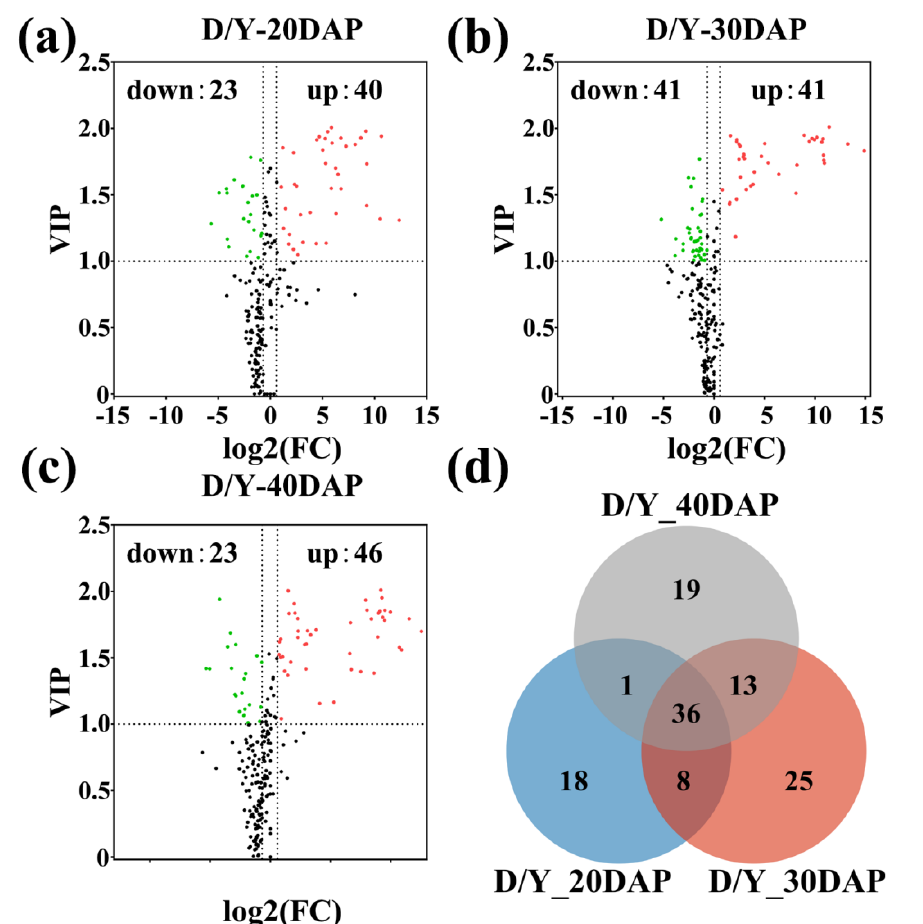
Figure 2. Identification of common differentially abundant metabolites in developing seeds of B . juncea . ( a–c ) Volcano plots of differentially abundant metabolites. Each point in a volcano plot represents a metabolite; the abscissa represents the logarithm of the quantitative difference multiples of a metabolite in two samples, and the ordinate represents the variable importance in project (VIP) value. The green dots represent down-regulated differentially abundant metabolites, the red dots represent up-regulated differentially abundant metabolites, and the black dots represent metabolites with no difference. ( d ) Venn diagram of differentially abundant metabolites in developing seeds of B. juncea. DAP = days after pollination.